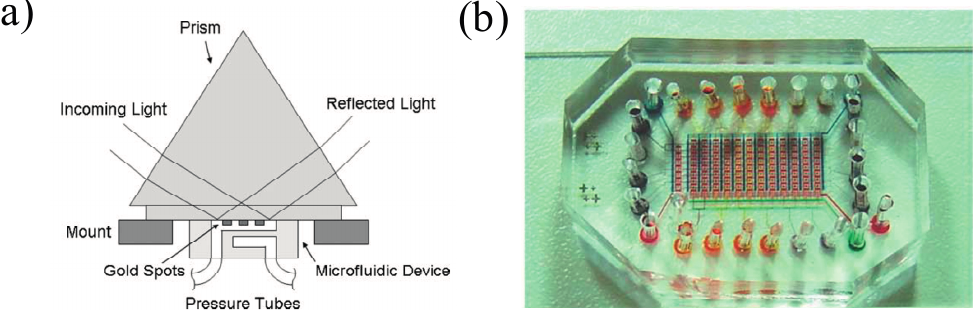
Figure 7. ( a ) The conventional configuration for SPR imaging system. A collimated laser beam ( λ = 625nm) is passed through a prism and illuminated on the gold spots. The reflected beam is collected by a digital imaging device. All binding events on the gold spot in the microfluidic channel are monitored in real-time. ( b ) Image of the microfluidic device in which valves and channels are integrated. To visualize the valves and channels, a food color dye is injected (Reproduced with permission from